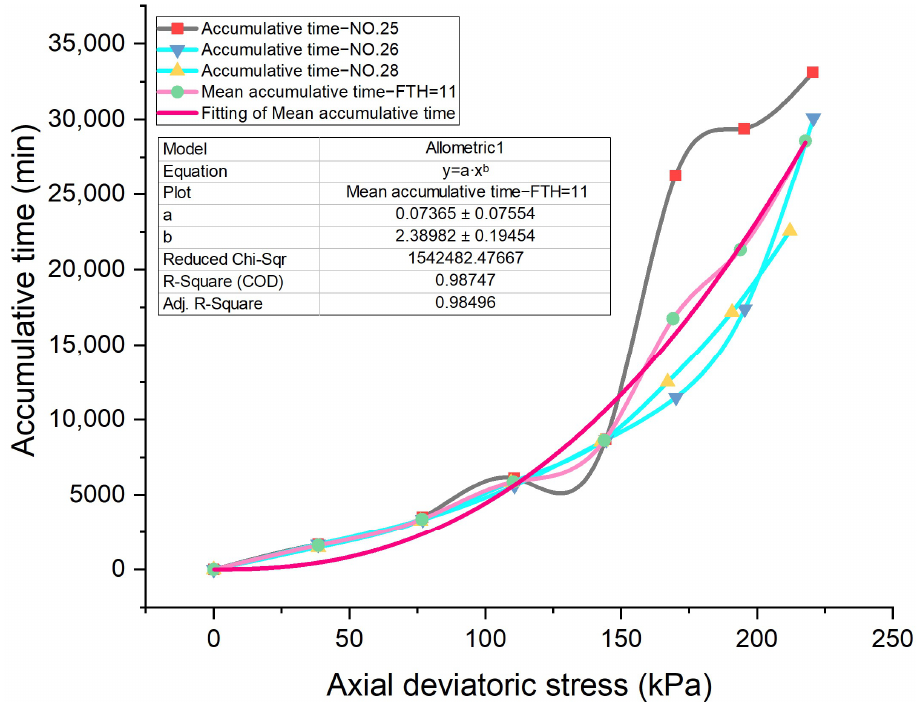
Figure 28. Accumulative time–axial deviatoric stress curves when FTH = 11. Here, the rate of time that specimens took to deform, which agrees with ≤ 0.06 mm/ 1440 min, was extracted from each specimen. The time t (min) correlates with the axial deviatoric stress ( σ 1 − σ 3 ) (kPa) in approximate functions after going through 4, 7